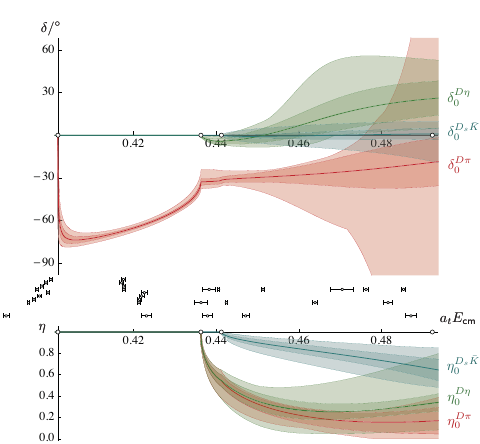
Figure 5. The upper (lower) panel shows the S-wave phase shifts (inelasticities) for the D π (red), D η (green) and D s ¯ K (blue) channels, where the size of the bands incorporates all T-matrix parametrizations of the S-wave. The black points show the lo- cation of the finite-volume energy levels used to constrain the parametrizations. Figure from